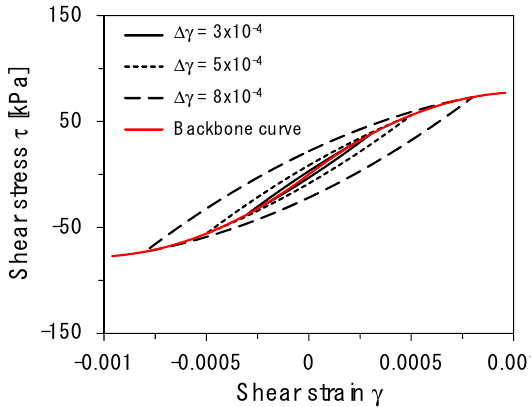
Figure 1. Nonlinear stress-strain behavior of sand under 200 kPa for three different shear strain amplitudes ∆ γ = 3 × 10 − 4 , 5 × 10 − 4 , 8 × 10 − 4 . Hysteretic loops and backbone curve are obtained using Equations (1) and (2) with G 0 = 146 GPa and α = 470.